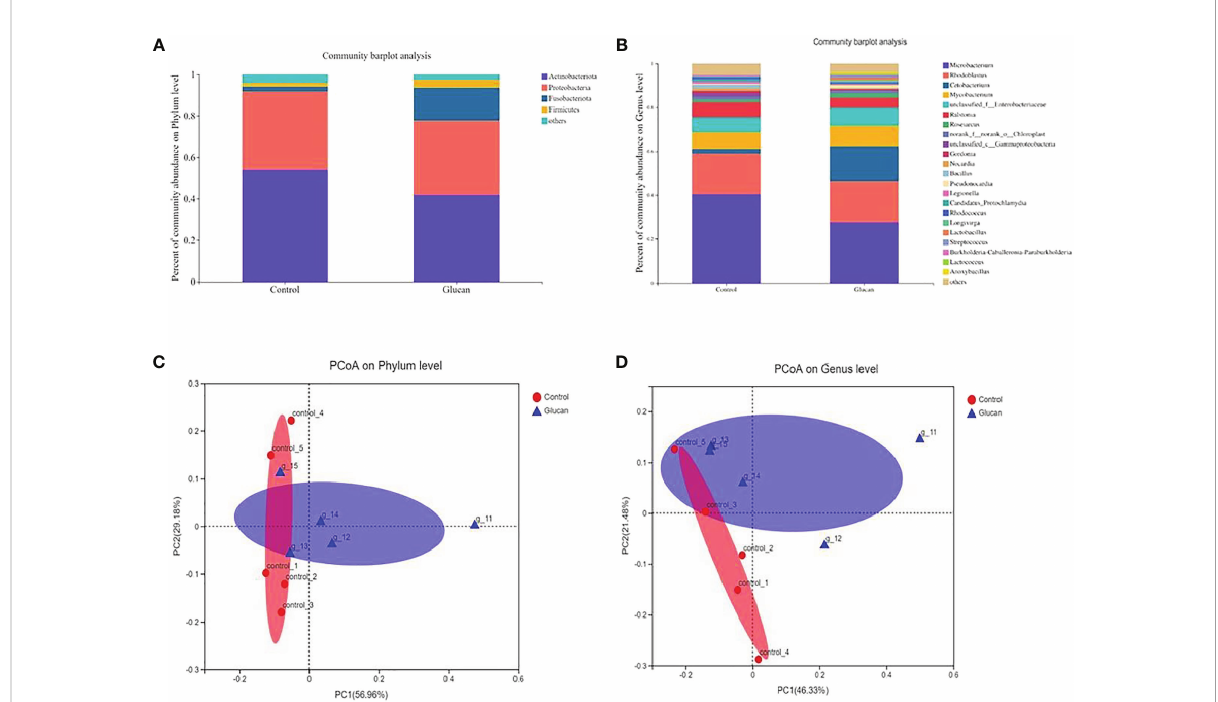
FIGURE 9 The composition of gut microbiota in zebra fi sh fed with or without 0.025% b-glucan diets. The composition of gut microbiota in zebra fi sh was analyzed using 16S rRNA sequencing analysis. (A) Relative abundance at the phylum level between the two groups; (B) Relative abundance at the genus level between the two groups; (C, D) Principal coordinate analysis (PCoA) of all samples by weighted UniFrac